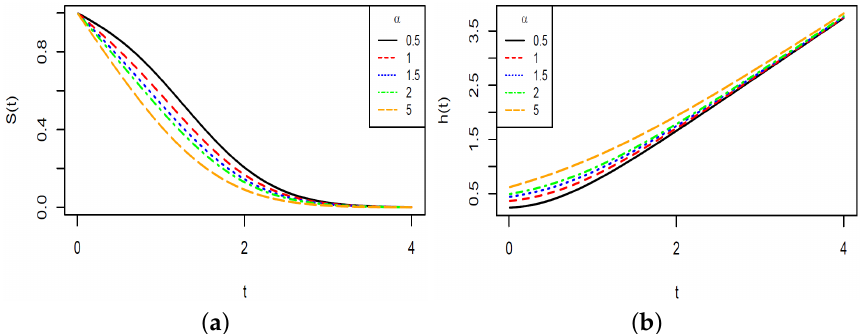
Figure 3. ( a ) Plots of the survival function for the EHSN ( α , 1, 0.1 ) . ( b ) Plots of the hazard rate function for the EHSN ( α , 1, 0.1 )